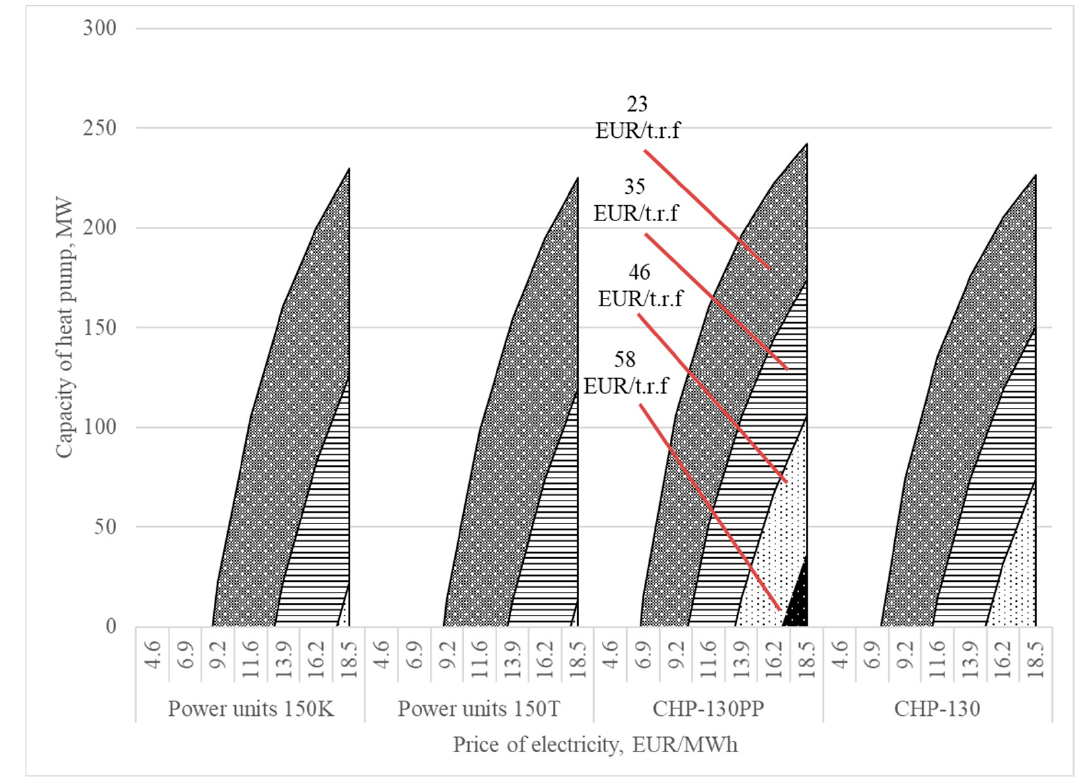
Figure 10. The range of permissible HP capacities with a TPP capacity of 130–150 MW.